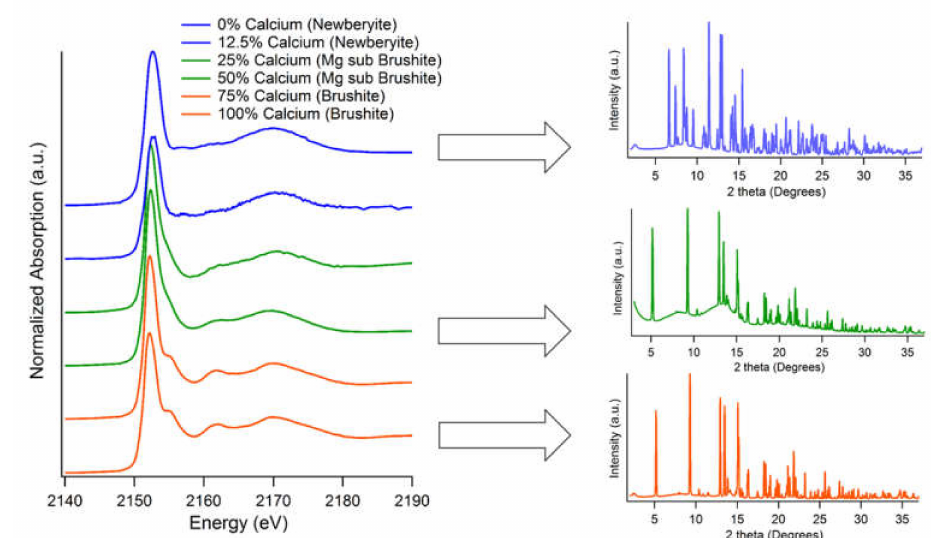
Figure 1. XANES and XRD patterns of acidic / neutral mineral series. Blue spectra / patterns indicate magnesium phosphates, green spectra indicate minerals formed in mixed cation solutions with unique characteristics, and orange spectra are crystalline calcium phosphates. Percentages refer to initial solution composition during synthesis.